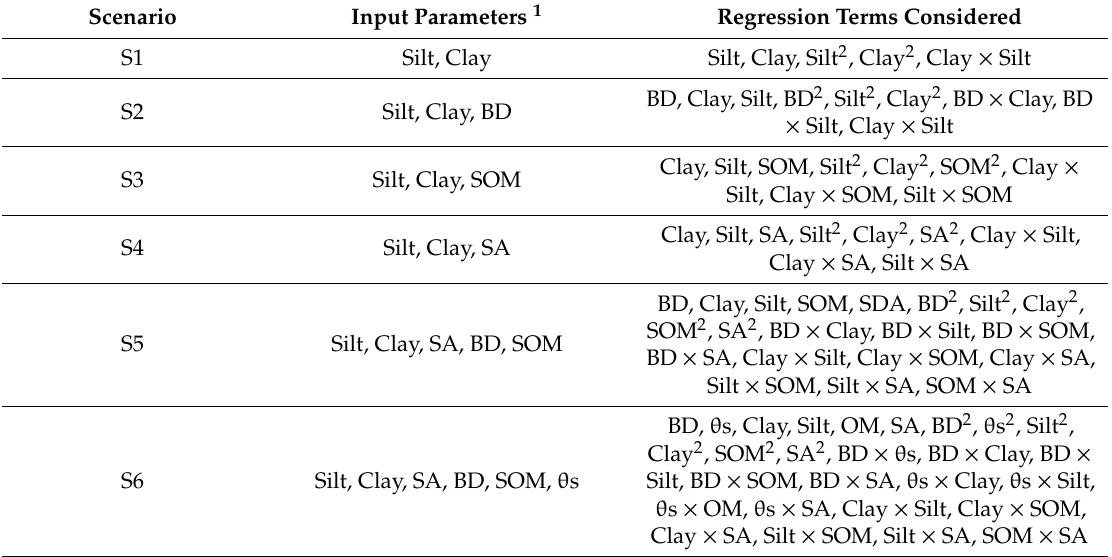
Table 3. Combinations of input attributes used and the regression terms considered to develop parametric pedotransfer